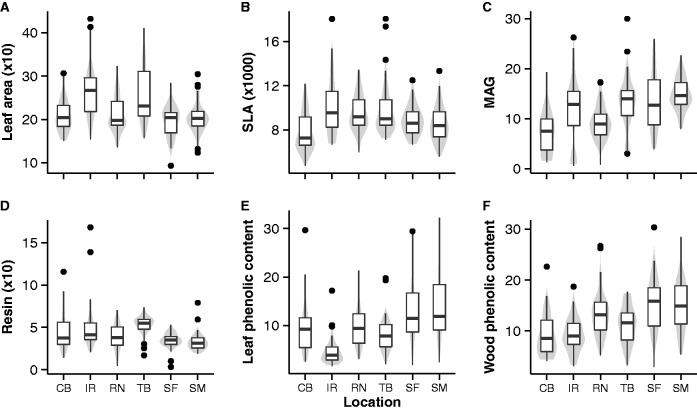
Trait variations among the studied Pinus taeda invasive populations. Violin plots and boxplots of (A) leaf area (mm2), (B) specific leaf area (SLA, mm2/g), (C) mean annual growth (MAG, mm), (D) non-volatile wood resin content (mg/g), (E) total needle phenolic content (mg/g) and (F) total wood phenolic content (mg/g) for each invasive population (CB, Capão Bonito; IR, Irati; RN, Rio Negro; SF, São Francisco de Paula; SM, Santa Maria; TB, Três Barras). Violins (grey areas) are kernel probability densities of the data at different values. Boxplots are median (bold black line), quartiles (white rectangles), standard deviation (black lines) and possible outliers (dots).